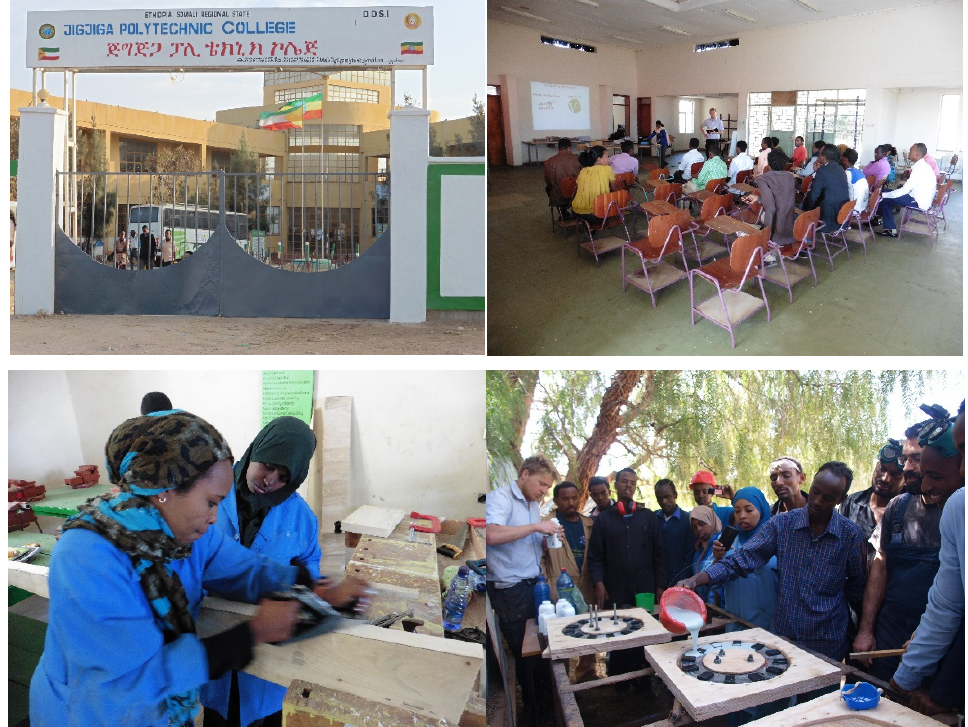
Figure 2. Small wind turbine construction course at the Jijiga Polytechnic College. Reprint with permission, rurerg.net (accessed on 24 May 2022).